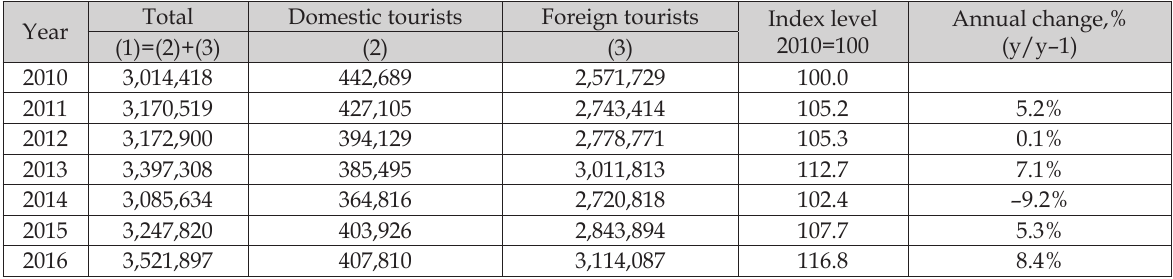
Table 2. Overnight stays in collective accommodation in Montenegro (Montstat